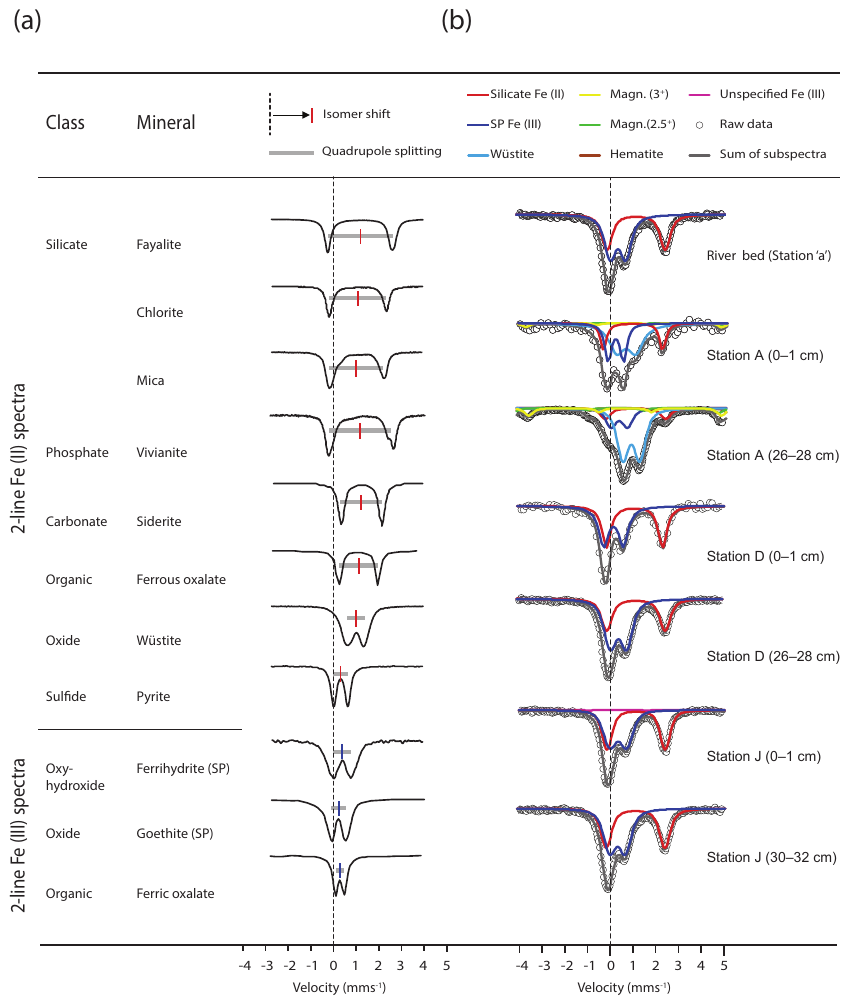
Figure 7. (a) Room temperature (RT) two-line Mössbauer 57 Fe reference spectra from various sources. Spectra have been trimmed and normalized for visual intercomparison. The arbitrary y axis indicates the intensity of gamma-ray transmission, hence troughs correspond to absorption maxima. Spectra for fayalite, chlorite, mica, vivianite, siderite, wüstite, pyrite and ferrihydrite are reproduced by permission of M. Darby Dyar from the Mineral Spectroscopy Database of Mount Holyoke College. These spectra are previously unpublished with the exception of fayalite (Belley et al., 2009) and vivianite (Dyar et al., 2014). A plot digitization software was used to extract Fe (II) and Fe (III) oxalate spectra from D’Antonio et al. (2009), and a superparamagnetic goethite (goethite SP) spectrum from van der Zee et al. (2003). The isomer shift and quadrupole splitting of each spectrum are indicated. Note that with the exception of pyrite, Fe (II) phases typically show a more positive isomer shift (position of center of doublet relative to zero velocity) and larger quadrupole splitting (distance between two peaks of a doublet on the velocity axis) than Fe (III) phases. (b) RT Mössbauer 57 Fe spectra from this study. Spectra have been trimmed and normalized, and all spectra are presented in the same orientation for visual intercomparison. Spectra from Station A 0–1cm and Station D 0–1cm were collected in backscatter mode, hence the troughs correspond to backscatter emission maxima. All other spectra were collected in transmission mode. See Fig. S2 for complete original spectra in true orientation, including six-line standards. The subspectra used in the model fit for each bulk spectrum are shown in the legend. Relative spectral areas of each component are given in Table 4.